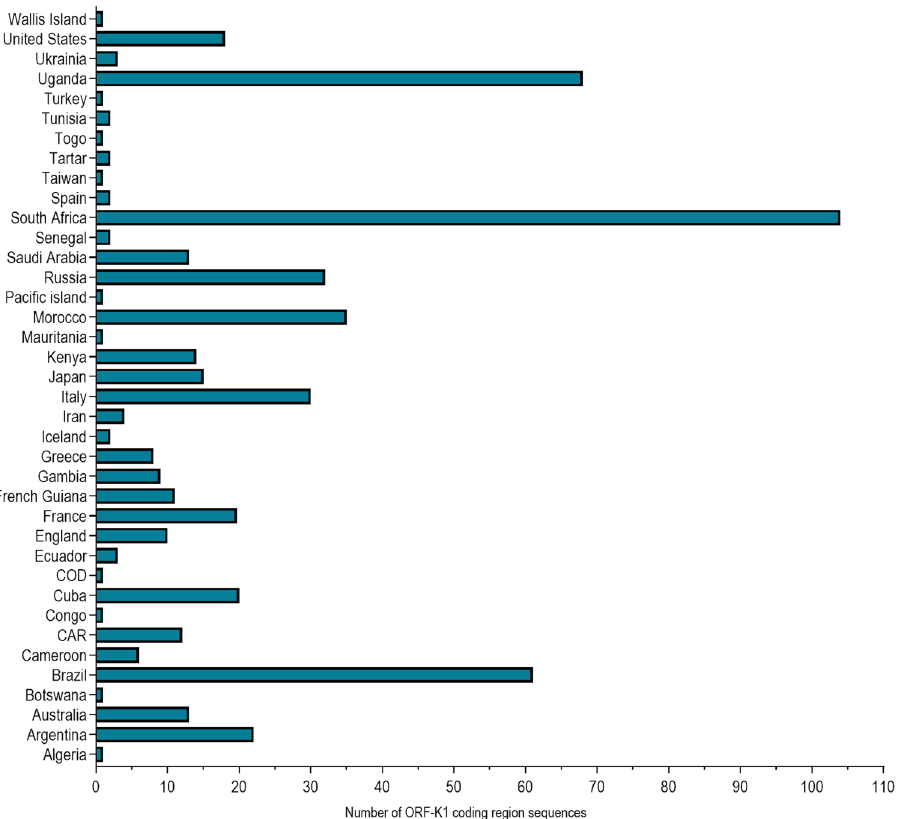
Figure 1. Number of HHV-8 ORF-K1 coding region sequences published per country/origin. Sequences were collected from GenBank. (CAR, Central African Republic; COD, Democratic Republic of the